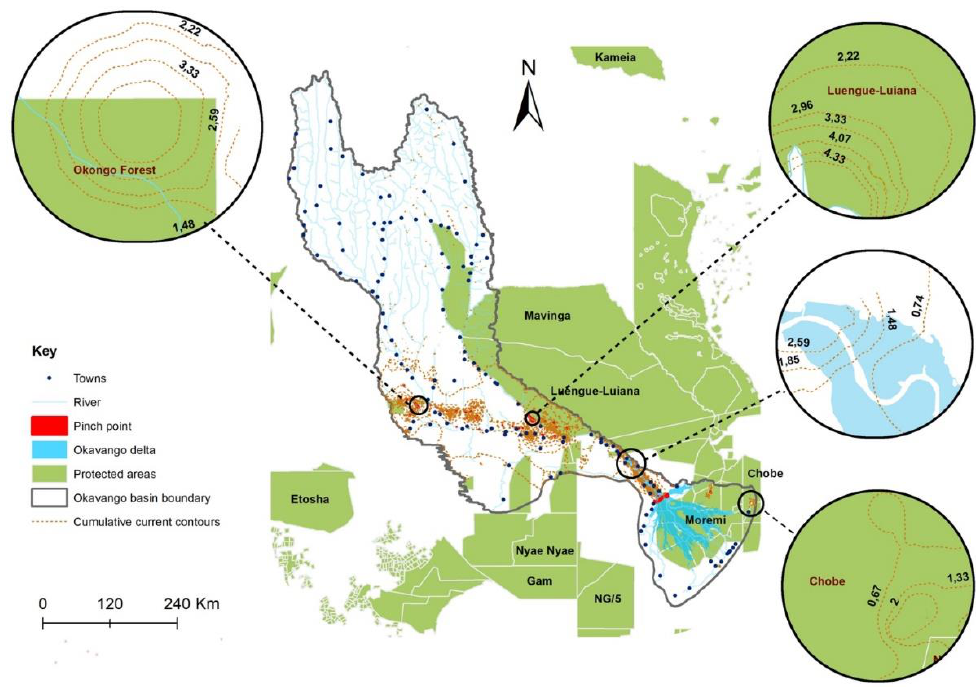
Figure 10. The map shows contours of cumulative current for Category C transitions (from natural- to-natural classes) in relation to towns and rivers and protected areas. The subfigures highlight how current ranges are influenced by the locations of selected towns and rivers in the basin.